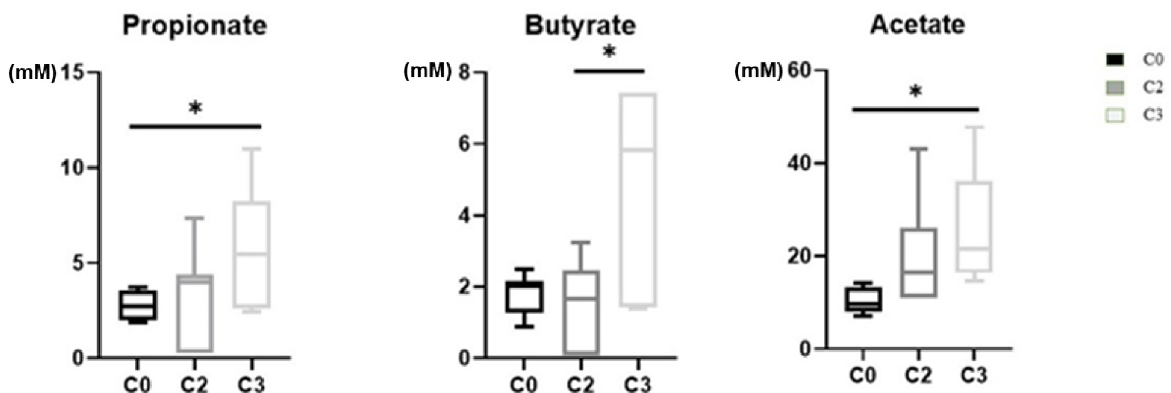
Figure 5. Metabolomic profile of SCFAs in the feces of BC patients undergoing NAC. After three cycles of NAC, three SCFAs (propionate, butyrate, and acetate) were significantly higher in the C3 group compared to the C0 group. SCFAs: short-chain fatty acids; NAC: neoadjuvant chemotherapy. *: indicates significant differences between the groups ( p -value < 0.05).